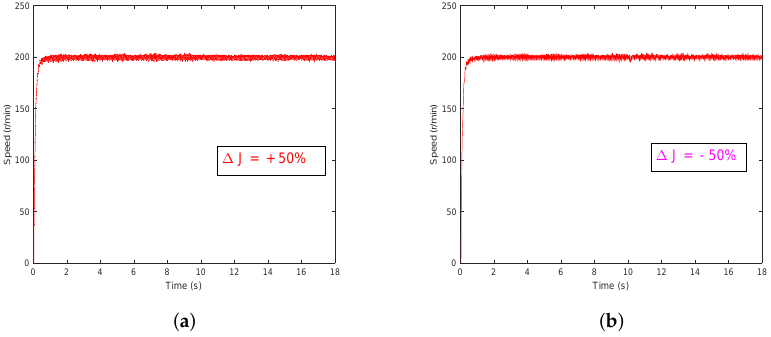
Figure 16. Speed response curves under GPC+ESO method with a sudden change of moment of inertia value. ( a ) ∆ J = + 50%; ( b ) ∆ J = −